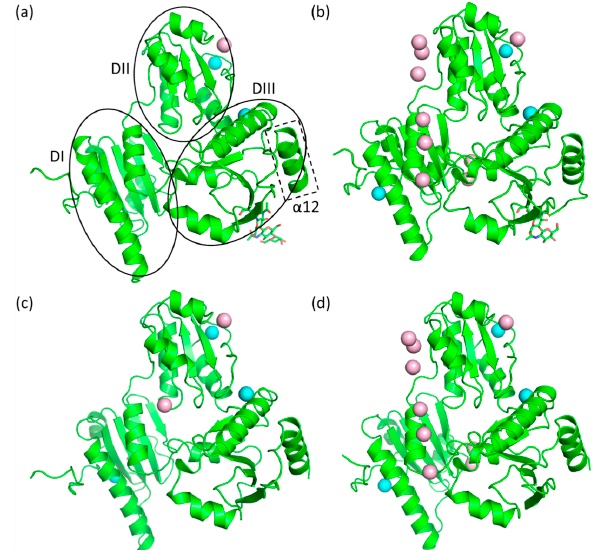
Figure 3. Crystal structures of ( a ) low-Ca 2+ native bovine Casq1; ( b ) high-Ca 2+ native bovine Casq1; ( c ) low-Ca 2+ recombinant bovine Casq1 and ( d ) high-Ca 2+ recombinant bovine Casq1. Cyan spheres represent Ca 2+ bound at high-affinity sites, and pink spheres are Ca 2+ bound at low-affinity sites. The glycosyl chains are represented as sticks. In ( a ), ovals and dotted lines indicate the boundary for the individual domains and C-terminal helix ( α 12).